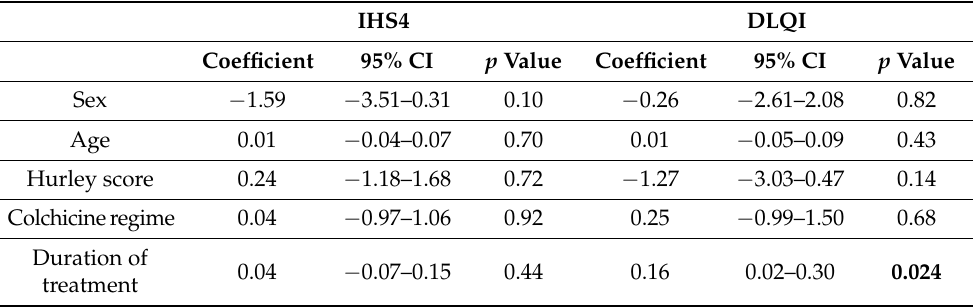
Table 4. Results of multivariable linear regression analysis for differences in IHS4 and DLQI scores as dependent variables and colchicine regime, sex, age, duration of treatment, and Hurley stage as independent